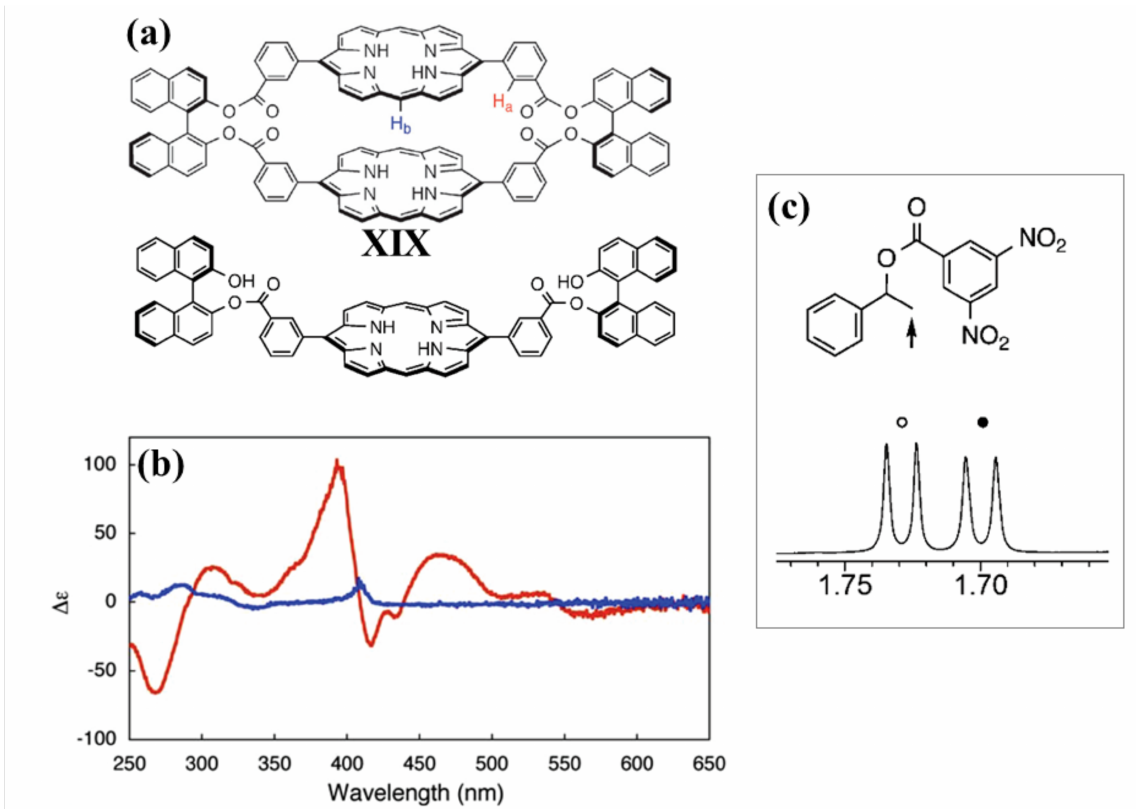
Figure 16. ( a ) Molecular structure of the chiral (R-) porphyrin dimer XIX (top) and the chiral monomer (bottom); ( b ) CD spectra of the chiral porphyrin dimer (red curve) and the corresponding chiral monomer (blue curve) in chloroform; ( c ) 1 H NMR of the racemic mixture of the ester of dinitrobenzoic acid in the presence of R- XIX in deuterated chloroform. In particular, the signals shown (bottom) refer to the protons indicated by the arrow. (R)- and (S)-enantiomer of the ester are labelled by filled and open circles, respectively. Adapted with permission from reference [76]; published by Royal Society of Chemistry